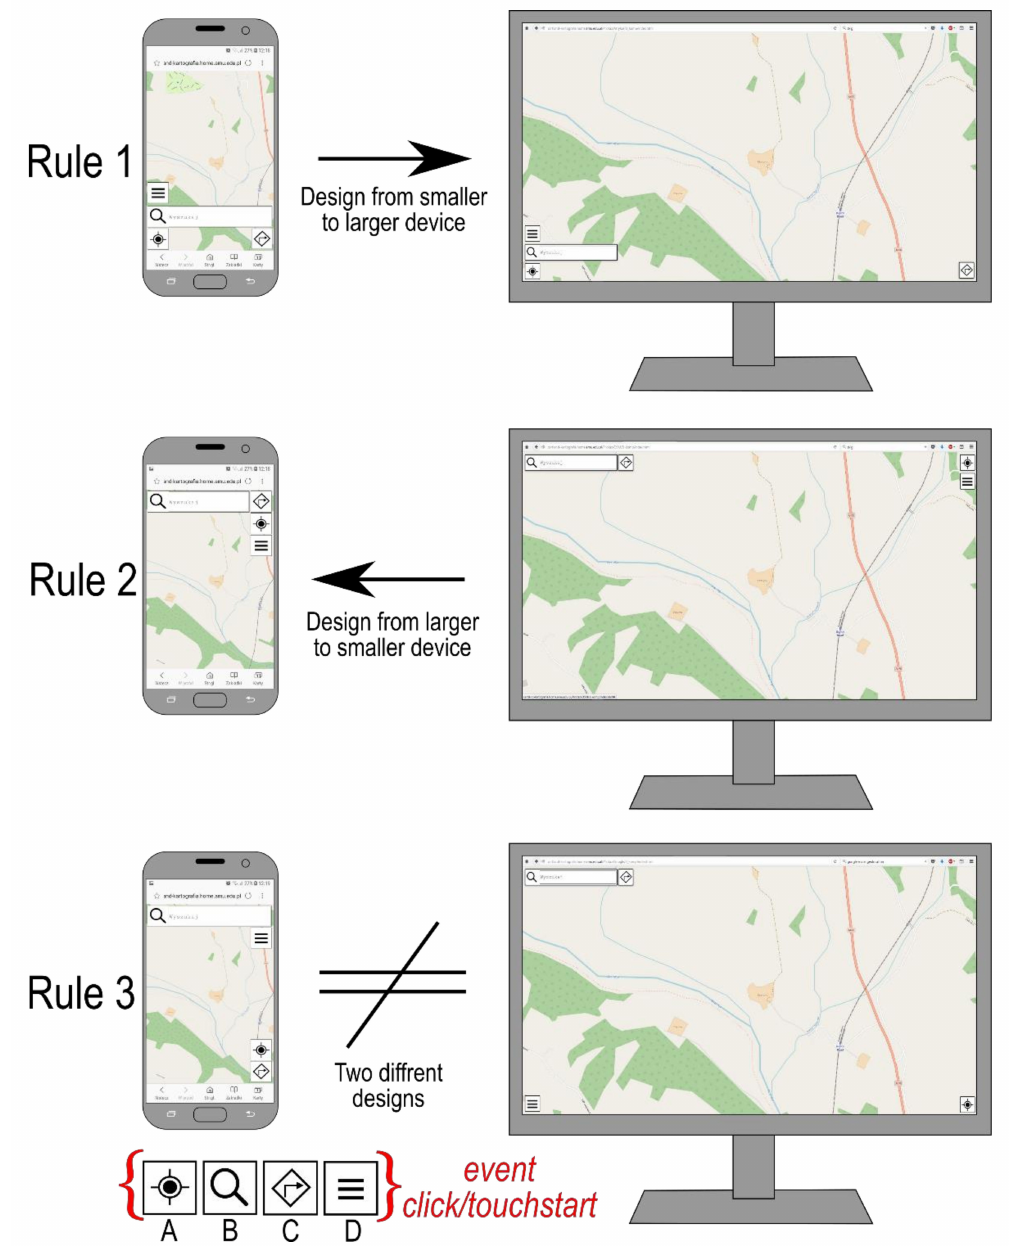
Figure 2. Variants of GUI (Graphical User Interface) design according to three rules (A—Geolocation, B—Search, C—Route, D—Change